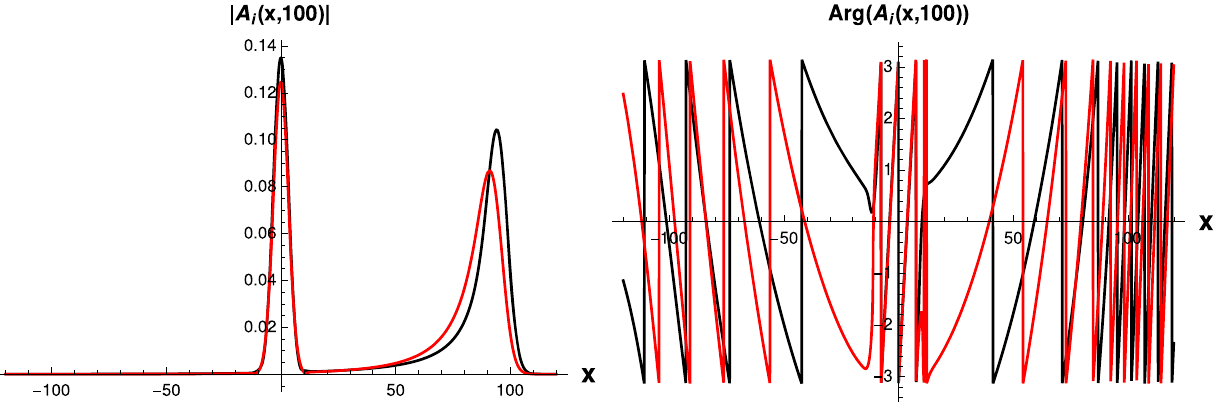
Fig. 2 The absolute values (left) and phases (right) of the amplitudes A i ( x , 100 ) calculated at time t = 100 in the classical source model. The black and red curves correspond to the m = 0 . 3 and m = 0 . 4 neutrino wave functions